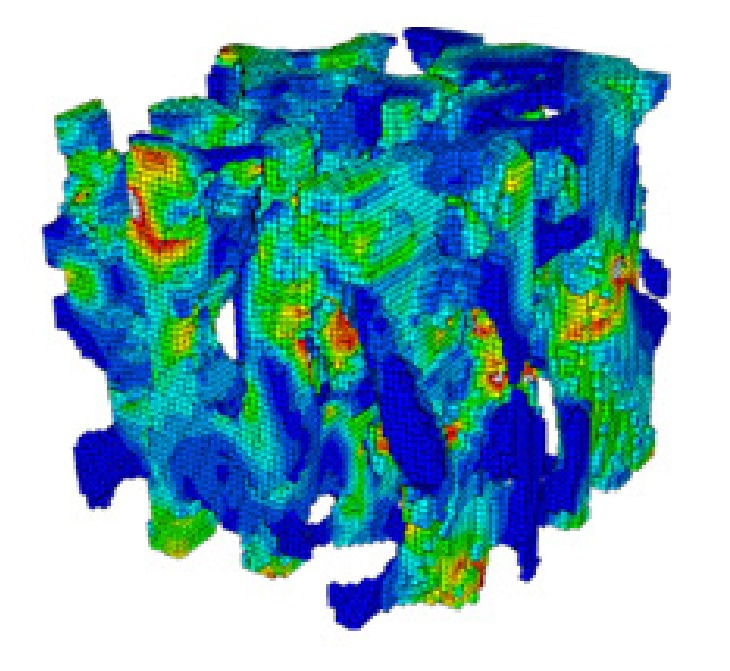
Hambli's [13] fatigue damage model.